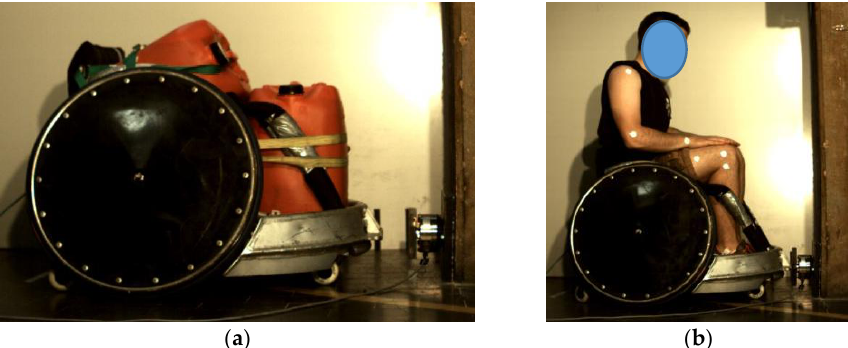
Figure 3. Configuration of dynamic calibration ( a ) wheelchair with water containers; ( b ) wheelchair with human tester.